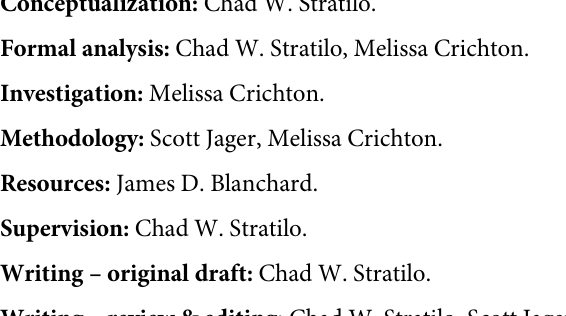
S1 Table. Survivor ship data from experiments. Days = number of days during experiment (Day 35 is end of experiment). 0 = survived, 1 = terminated. Groups of five mice per cage, rep- licate